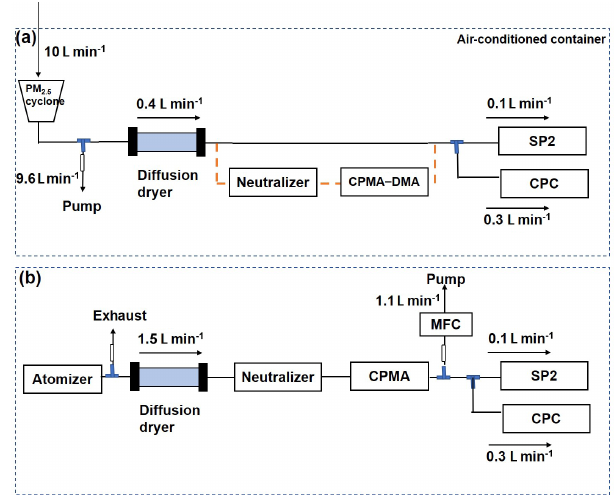
Figure 2. Schematic diagram of (a) the measurement system, with the orange dashed line denoting the tandem CPMA-SP2–DMA-SP2 measurement system, during the periods 9 and 13 June, and (b) the calibration